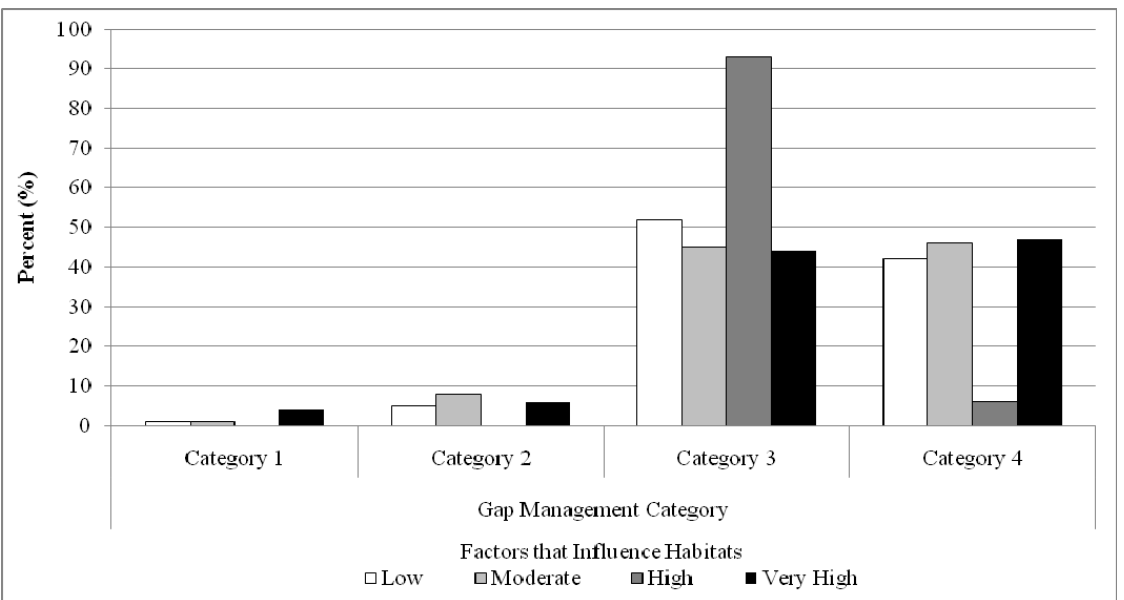
Figure 7. Percent of FIH categories in management intent categories (described in Table 1) in New